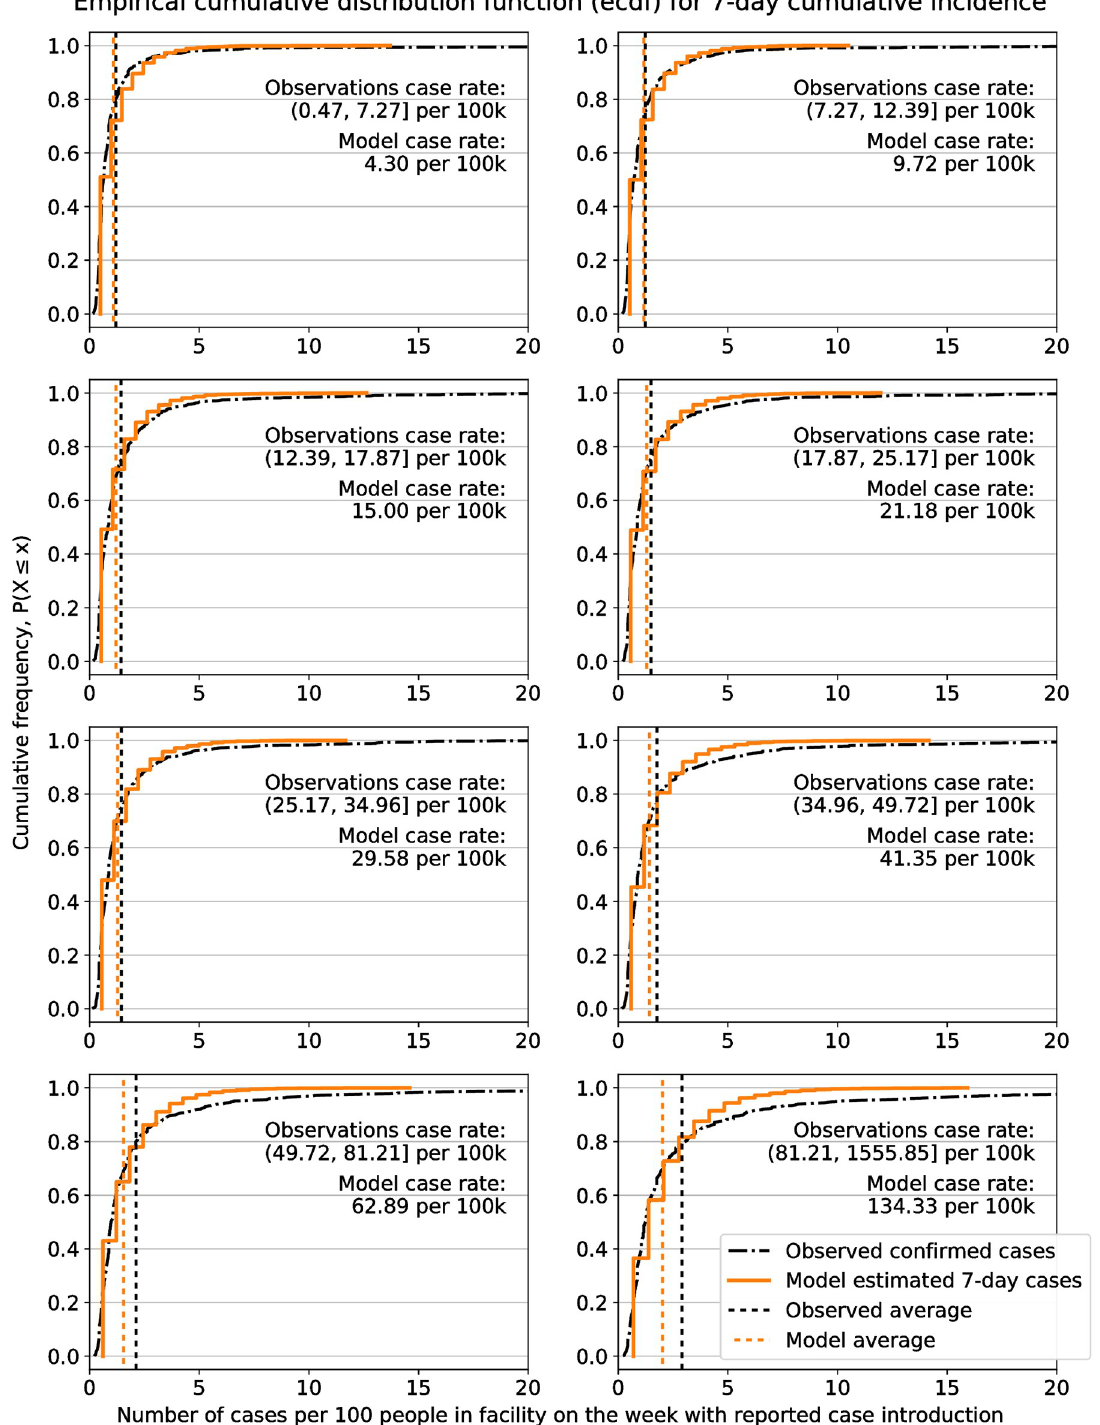
Fig 4. Distribution of 7-day cumulative incidence. Comparison of the distribution of cases per 100 people in nursing homes during the week of case introduction, and 7-day model simulations. Each subplot describes the distribution for facilities within one case rate category bin, and for the model based on corresponding mean case rate for that bin. Vertical dashed lines represent the average cases for the facilities and the simulations in each bin.